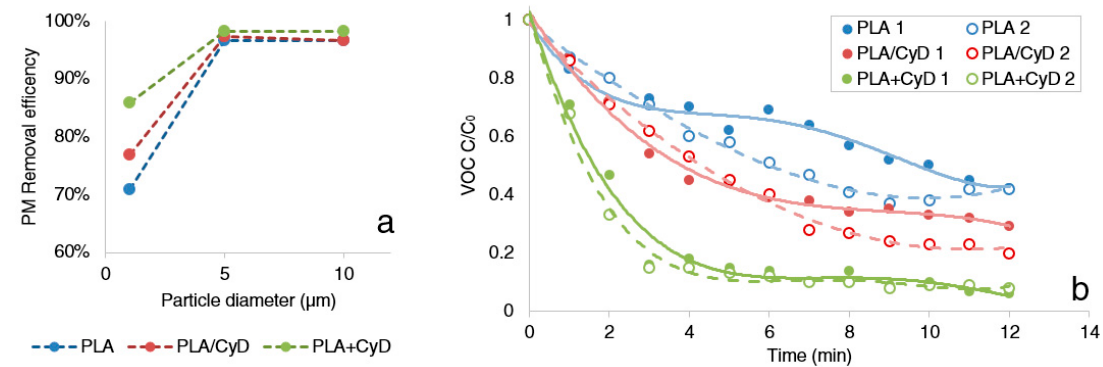
Figure7. ( a )PMremovale ffi ciencyand( b )normalizedvolatileorganiccompounds(VOC)concentration Figure 7. ( a ) PM removal efficiency and ( b ) normalized volatile organic compounds (VOC) concen- versus time by the di ff erent fibrous tration versus time by the different fibrous filters.